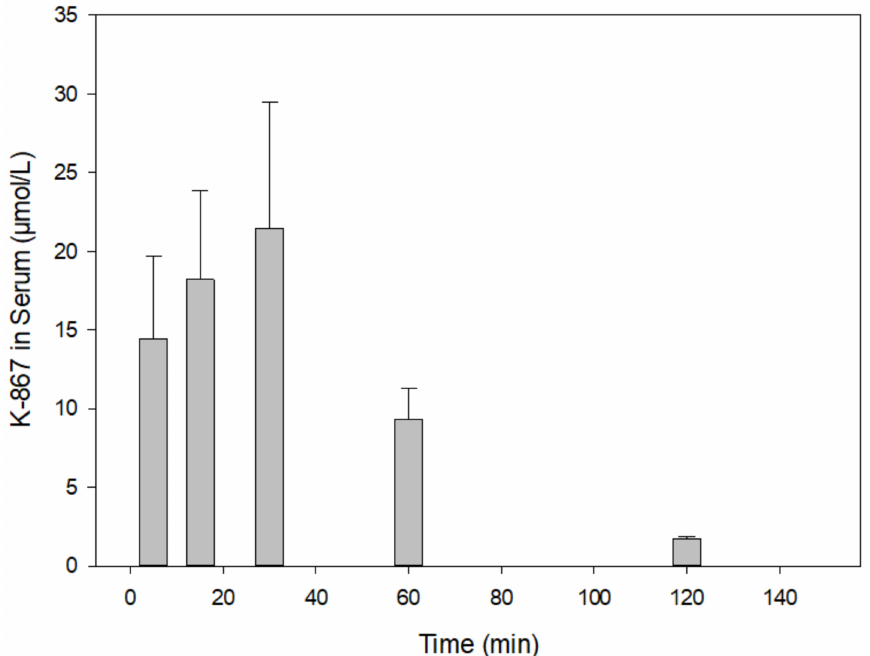
Figure 4. Time course of K-867 content in serum following its intramuscular administration of 3 µ mol. The results show the means and standard deviations obtained in 4 parallel treatments. The displayed concentrations are the means of 5 HPLC determinations each.